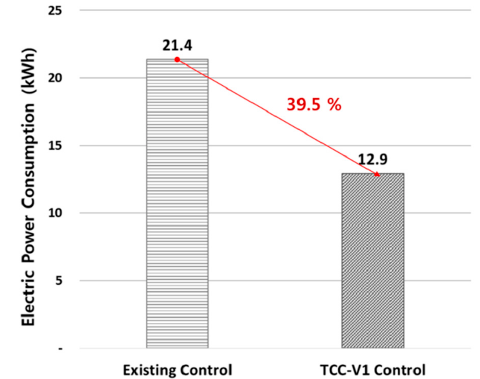
Figure 20. Comparison of electric energy consumption with and without TCC-V1 control on August 10.